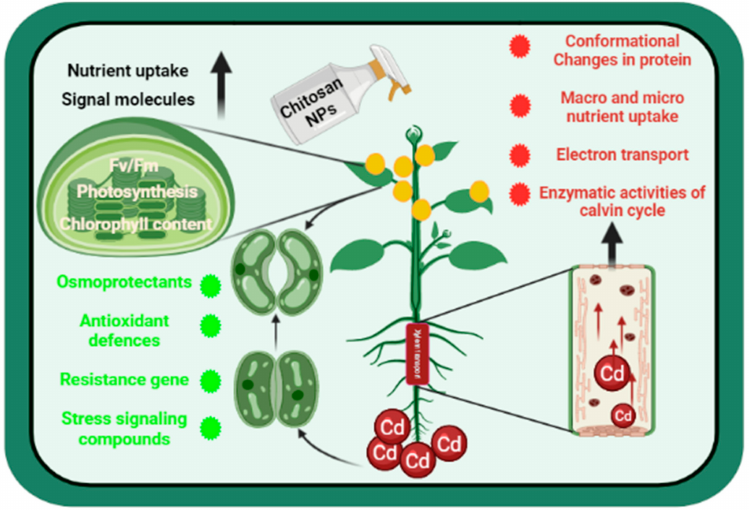
Figure 5. Schematic diagram shows the impact of chitosan nanoparticles to encountering the cad- mium stress in plants. Red and green dots indicate decrease and increase in a parameter,